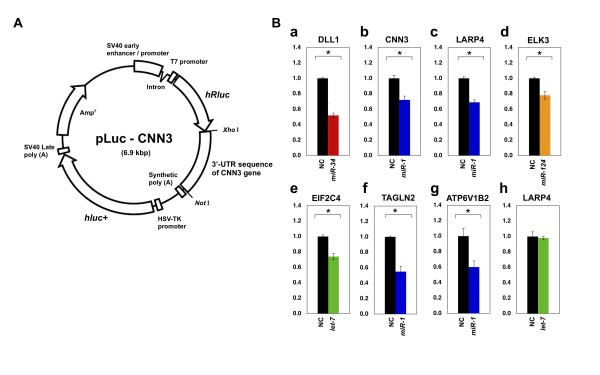
Example of the 3'-UTR reporter plasmid and experimental validation. The 3'-UTR sequences of DLL1, CNN3, LARP4, ELK3, EIF2C4, TAGLN2, and ATP6V1B2 were subcloned into the XhoI/NotI site of the psiCHECK™-2 vector. CNN3 was chosen as representative of the eight candidates listed above (see Methods section). (B) HeLa cells were cotransfected with each combination of 100 ng of reporter plasmid and the indicated amounts of each miRNA (DLL1, 5 pmol of miR-34 (a); CNN3, 60 pmol of miR-1 (b); LARP4, 20 pmol of miR-1 (c); ELK3, 60 pmol of miR-124 (d); EIF2C4, 60 pmol of let-7 (e), TAGLN2, 5 pmol of miR-1 (f), ATP6V1V2, 60 pmol of miR-1 (g), and LARP4, 60 pmol of let-7 (h)). Colours depict each miRNA: miR-34 (red), miR-1 (blue), miR-124 (orange), let-7 (green), and negative control (black). The relative expression of the luciferase gene was measured 24 h after transfection. The normalized luciferase activity of the control vector was set as 1.0. The data represent the average of three experiments and SDs. * P < 0.01.